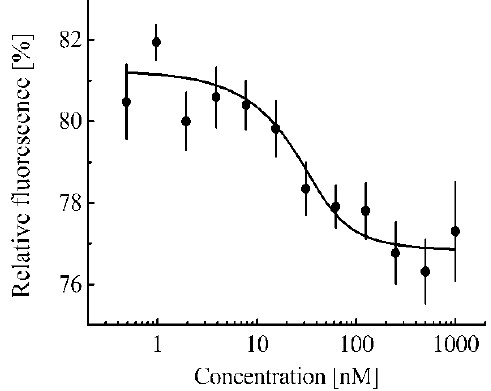
Figure 3. Dependences of relative fluorescence intensities (fluorescence intensity before the start of thermophoresis is taken as 100%) at 20 s after the start of thermophoresis on the concentration of the fmKeap1 protein at a constant concentration of the tKeap1 (40 nM). Standard errors (SE) of relative fluorescence intensities are shown ( n = 8–12).